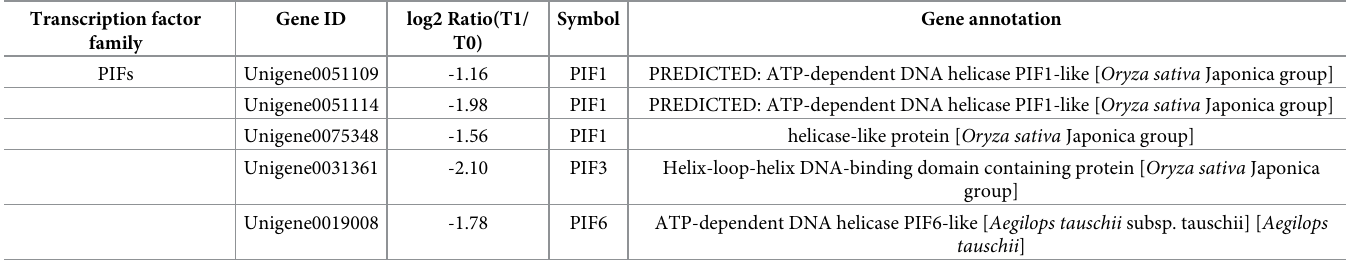
Table 4. Differentially expressed transcription factors associated with chlorophyll biosynthesis in Pennisetum setaceum ‘Rubrum’. Transcription factor